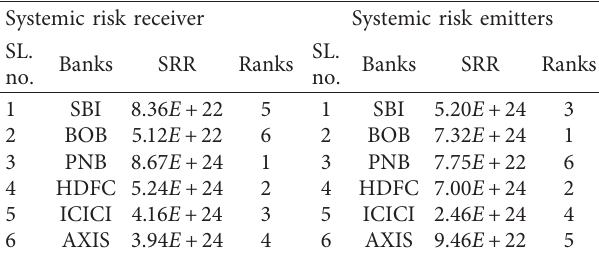
Figure 4: Interconnectedness of all the Indian banks. Table 7: Rankings of Indian banks based on the market